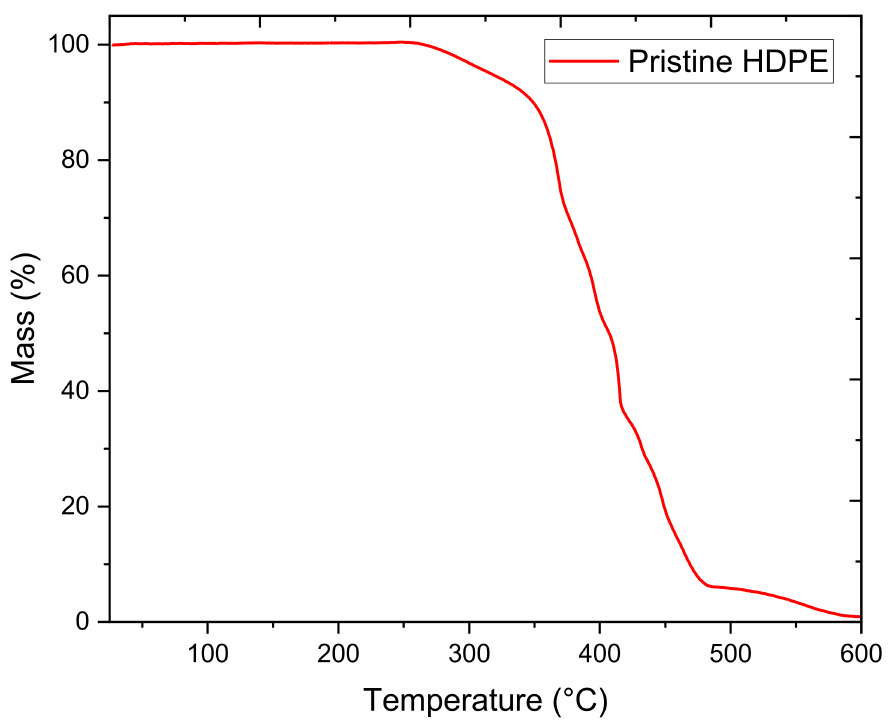
Figure 5. Thermal results of pristine HDPE obtained by TGA.